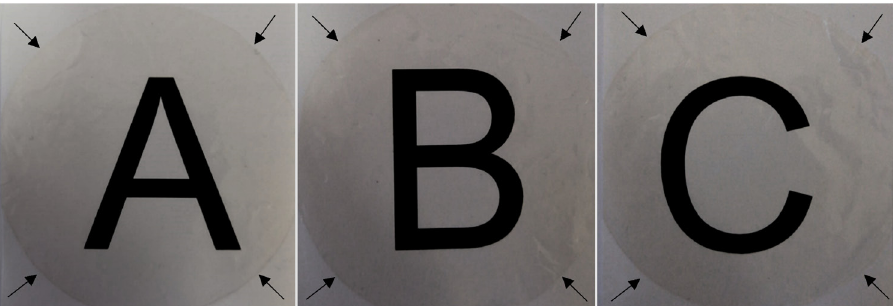
Figure 2. Picture of the membranes of PEC-CAR 0.25% ( A ), PEC-CAR 0.50% ( B ) and PEC-CAR 1.00% ( C ). Black arrows indicate the outline of the